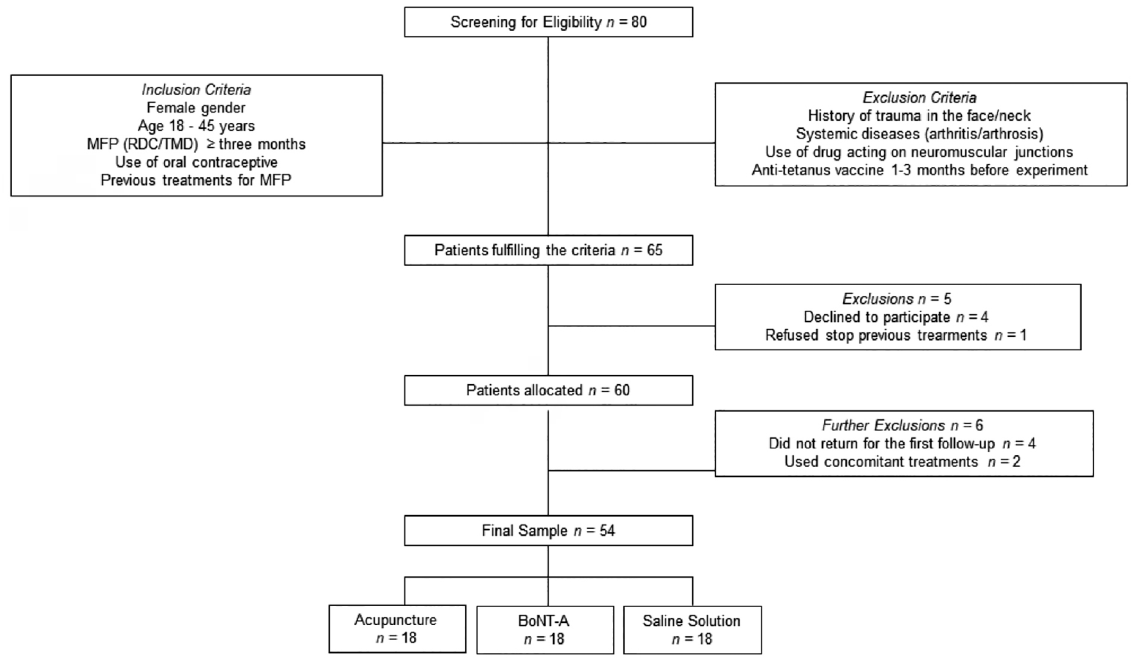
Figure 1- Flowchart of participants